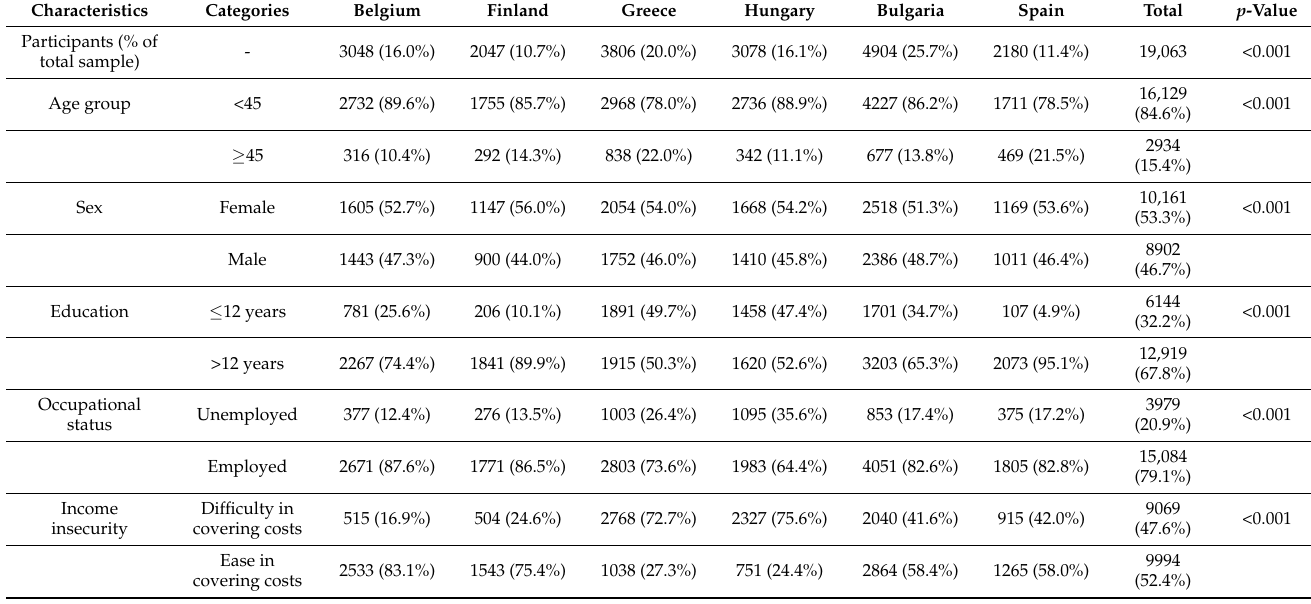
Table 1. Descriptive table of participants’ baseline characteristics.